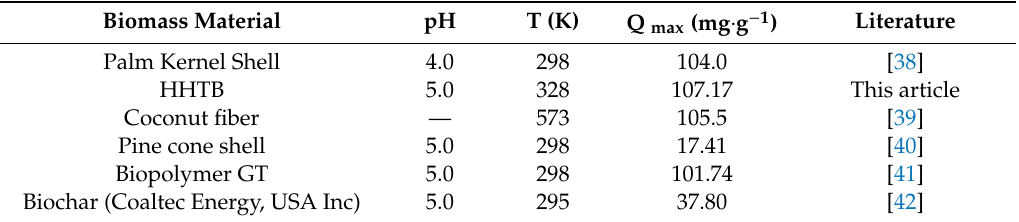
Table 1. Comparison of Pb 2 + maximum adsorption capacity (Q max ) between HHTB and other biomass